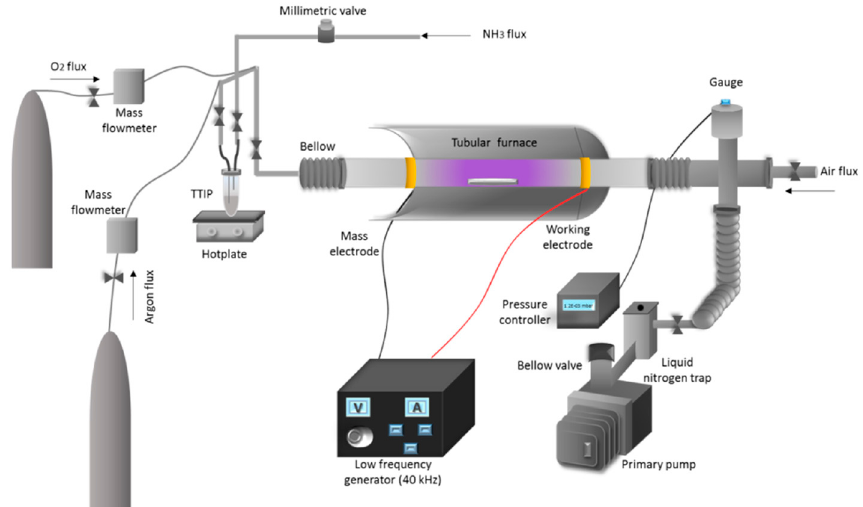
Figure 6. Schematic view of the capacitively-coupled low frequency PECVD reactor. Adapted with permission from Reference [52]. Copyright (2017) Elsevier.